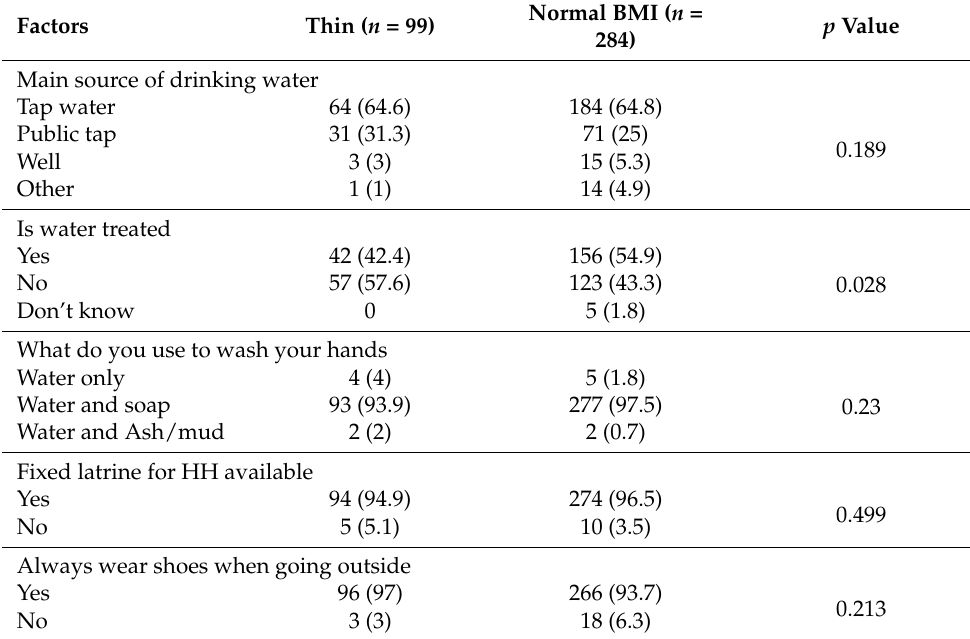
Table 5. Water, sanitation and hygiene at home factors for thin and normal BMI students.